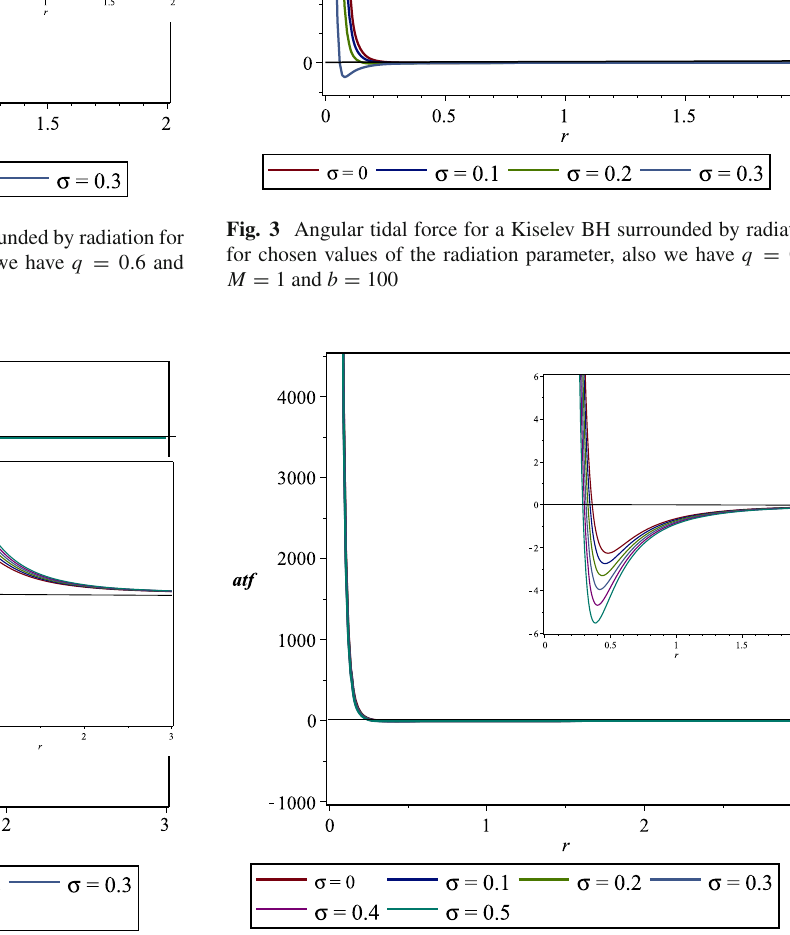
the event horizon and the Cauchy horizon. The angular tidal forces for different choices of σ r and σ d for a Kiselev BH surrounded by radiation and dust are given in Figs. 3 and 4. The local minimum of the radial tidal force for radiation is greater than for dust near the singularity.